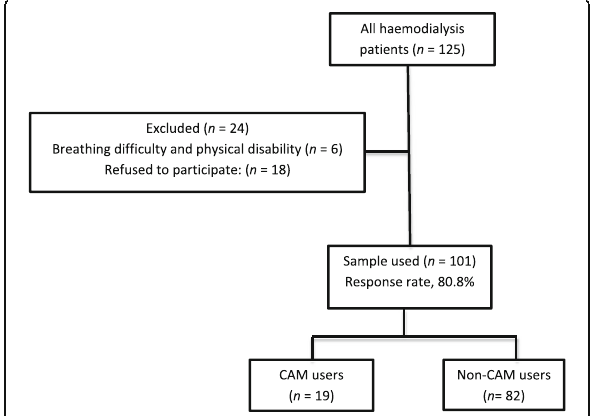
Fig. 1 Flow chart of the total patient population, respondents, and CAM users/nonusers. CAM, complementary and alternative